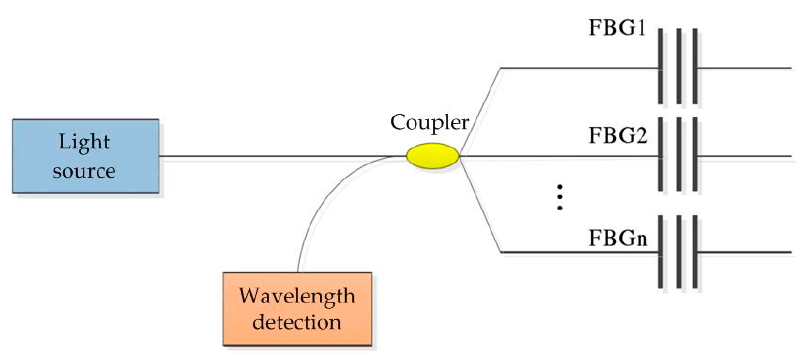
Figure 10. Schematic diagram of spatial division multiplexing technology.